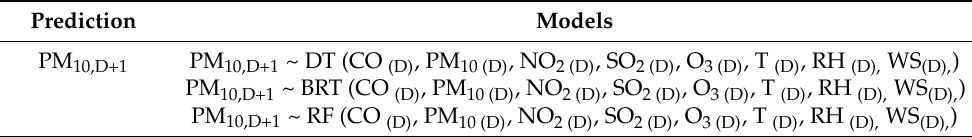
Table 2. General model for the next day’s prediction.